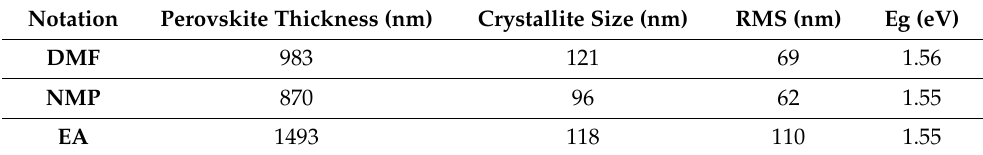
Figure 2. X-ray diffraction of the perovskite films prepared with different solvent mixtures. The perovskite crystallite size was estimated by the Scherrer equation [28], using the full width at half maximum of the (101) perovskite peak (Table 2). Perovskite films have similar crystallite size ranges in the case of NMP or EA mixtures, around 100 nm, comparable to the literature reports [29]. Table 2. Crystallite size and corresponding band gap values of fresh